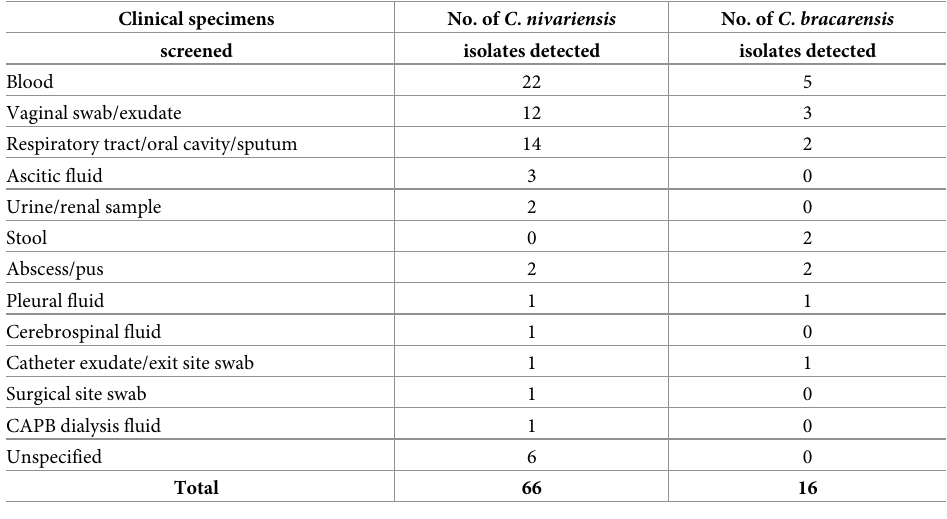
Table 2. Number of C . nivariensis and/or C . bracarensis isolates identified in various clinical specimens among ~6500 C . glabrata sensu lato isolates screened so far. Clinical